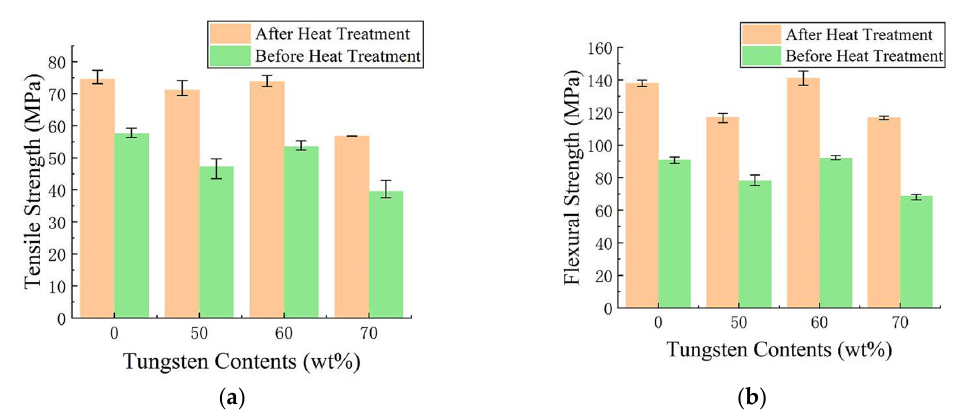
Figure 12. Test results of tensile and flexural strengths of PEEK and PEEK/tungsten composites: ( a ) tensile strength and ( b ) flexural strength.